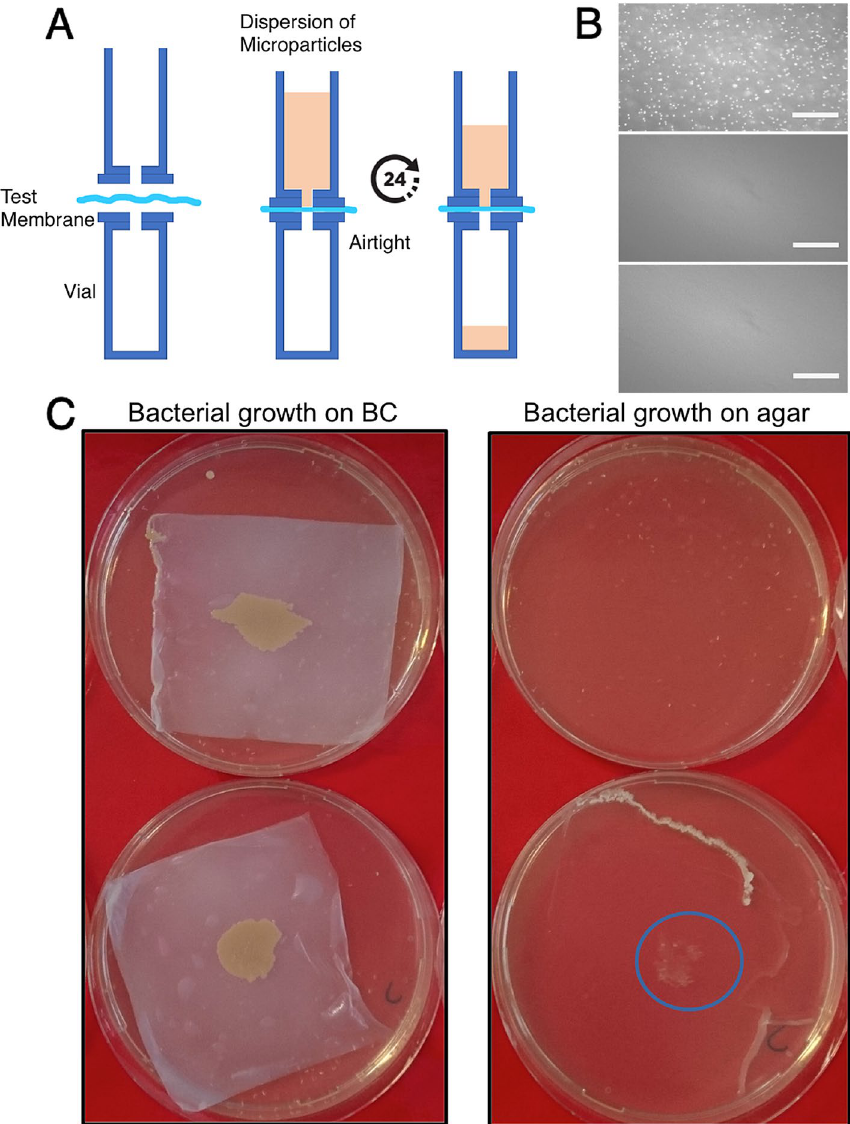
Figure 3. In vitro test of BC barrier function. ( A ) Experimental settings. A test BC membrane separates two chambers assembled with an airtight seal. A dispersion of microparticles is loaded into the upper chamber and let to diffuse for 24 h. ( B ) Direct evaluation of microparticle penetration (Dextran beads) across BC membranes. The upper surface of the BC membrane is reported as positive control (upper panel). The lower surface of the BC membrane upon incubation with Dextran beads (middle panel). The lower surface of BC membrane upon incubation with distilled water, reported as negative control (lower panel). ( C ) Bacterial colonization of pristine (upper left) and punctured BC membranes (lower left) and of the underlying agar substrate (right). A blue circle (lower right) indicates bacterial colonization underneath punctured BC